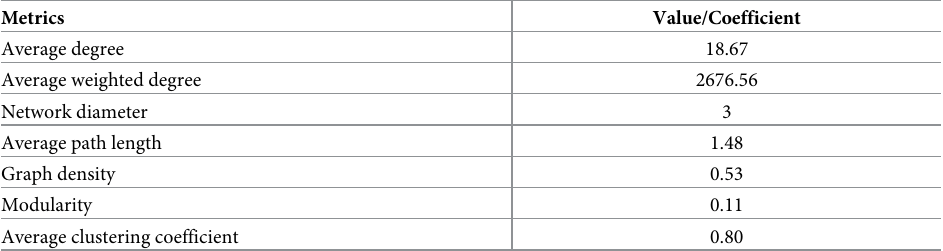
Table 7. The metrics related to the network of sectors based on common competencies.